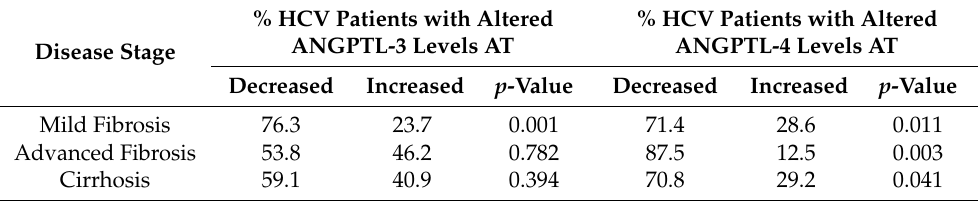
Table A1. Alteration in ANGPTL-3 and ANGPTL-4 serum levels of HCV patients after treatment (AT) depends on fibrosis stage upon DAA administration.